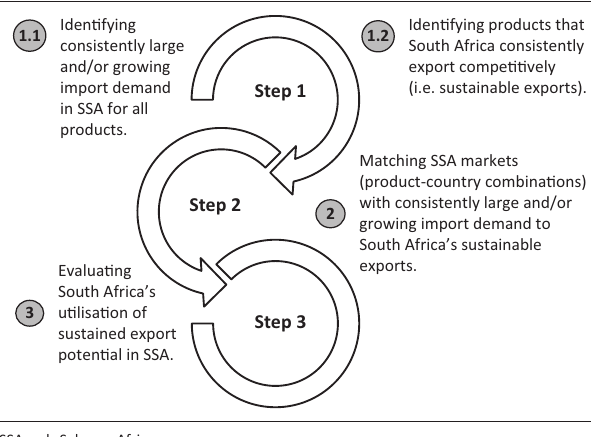
FIGURE 1: Diagrammatic representation of the methodological steps followed in this